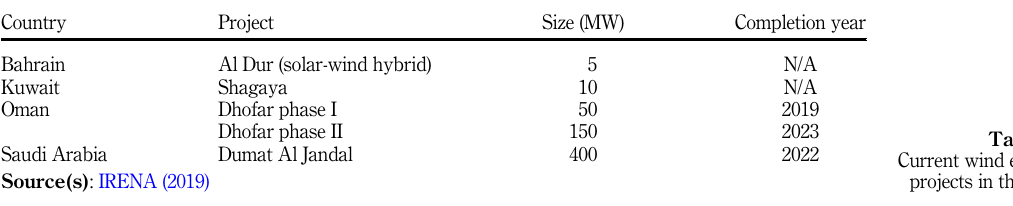
Table 1. Current wind